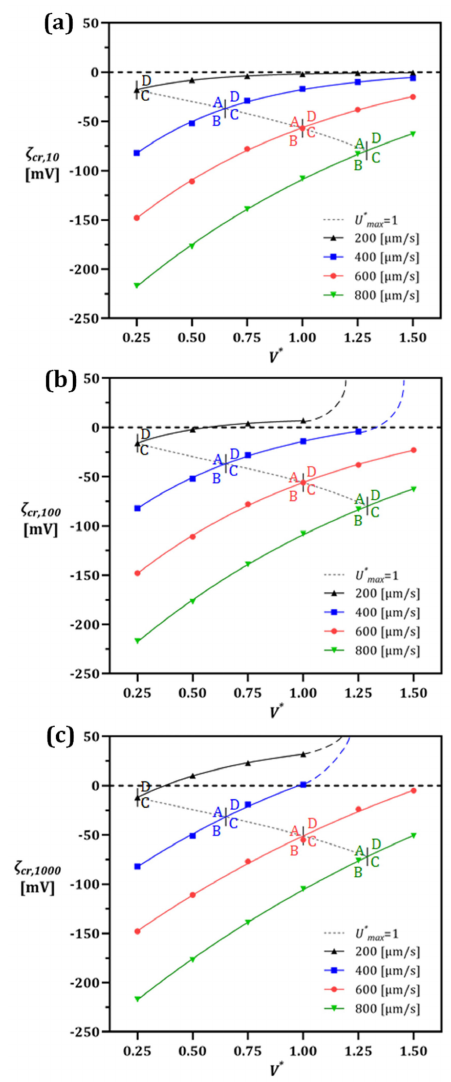
Figure 8. Critical ζ p for submicron particle sizes of ( a ) 10 nm, ( b ) 100 nm, and ( c ) 1000 nm at different inlet velocities and V ∗ . The intersections of critical ζ cr and U ∗ max lines divide the graphs into four regions at every flow rate, each representing a mode for the corresponding particle. As a result, particles with known charge and size can be separated by adjusting U L and V ∗ . Each letter demonstrates different modes, which introduced as A (Allowed), B (Blocked), C (Captured) and D